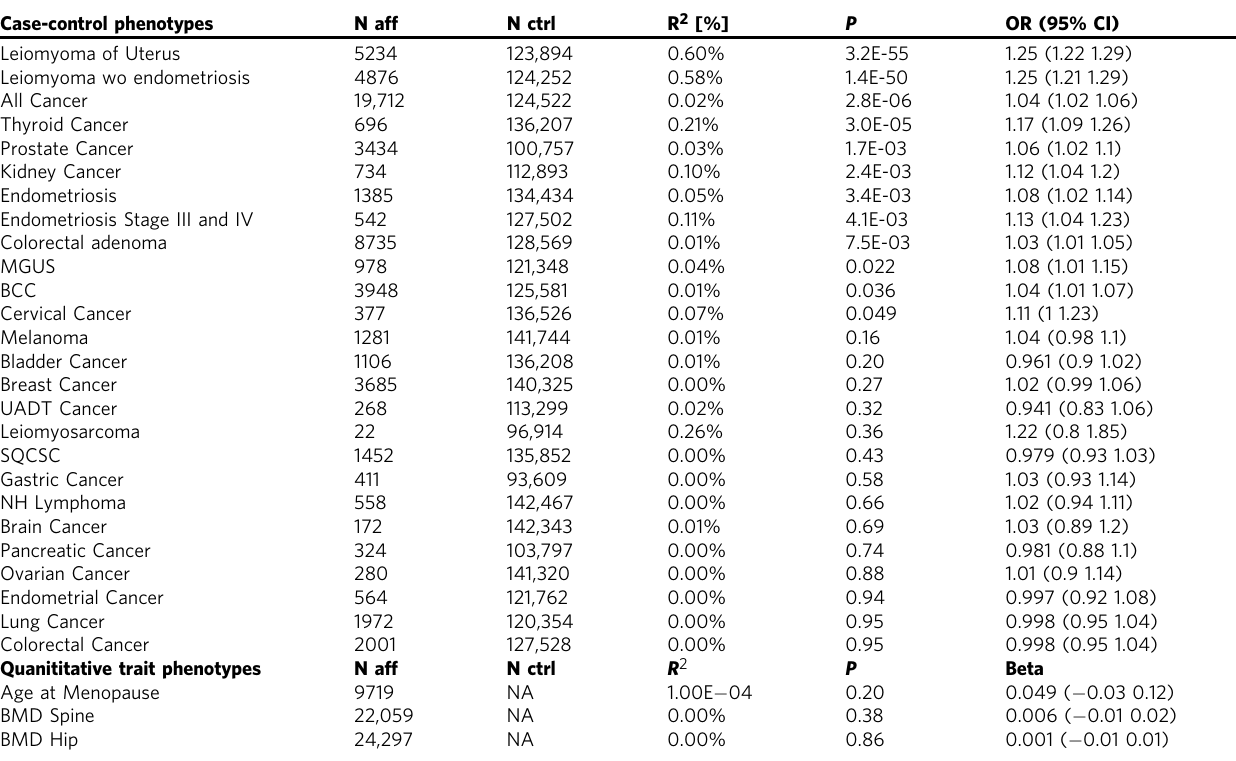
Table 2 Polygenic risk score analysis using chip-genotyped cases and controls in Iceland Case-control phenotypes N aff Leiomyoma of